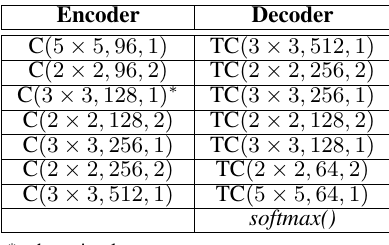
Table 1. Locations of the three test areas and size of the corresponding Landsat images.